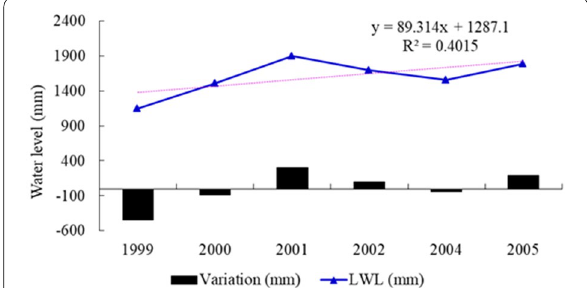
Fig. 5 The mean annual water level (free water surface gauge reading) and level variations (mean value deviations from